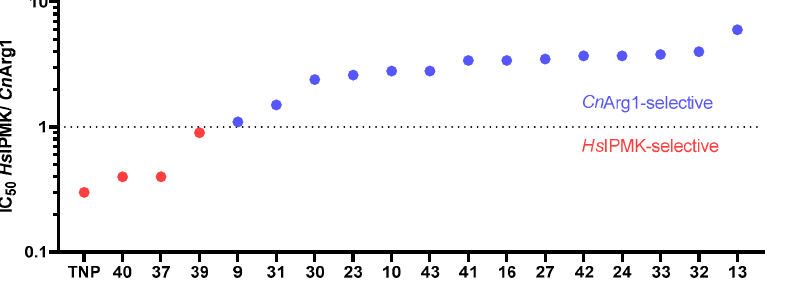
Figure 4. Selectivity of TNP and its analogues. The selectivity of TNP and the seventeen analogues with the lowest IC 50 against Cn Arg1, for Cn Arg1 (blue dots) and Hs IPMK (red dots), was determined by plotting the Hs IPMK/ Cn Arg1 IC 50 ratios.